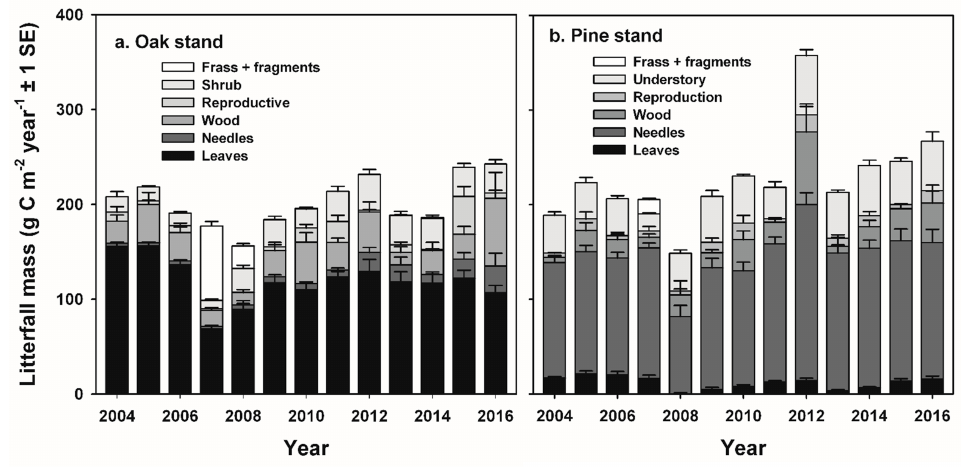
Figure A1. Litterfall (g C m − 2 year − 1 ) separated by component at the ( a ) oak and ( b ) pine stands. Values are means ± 1 SE from litterfall traps near the tower plots ( n = 10 for each stand).